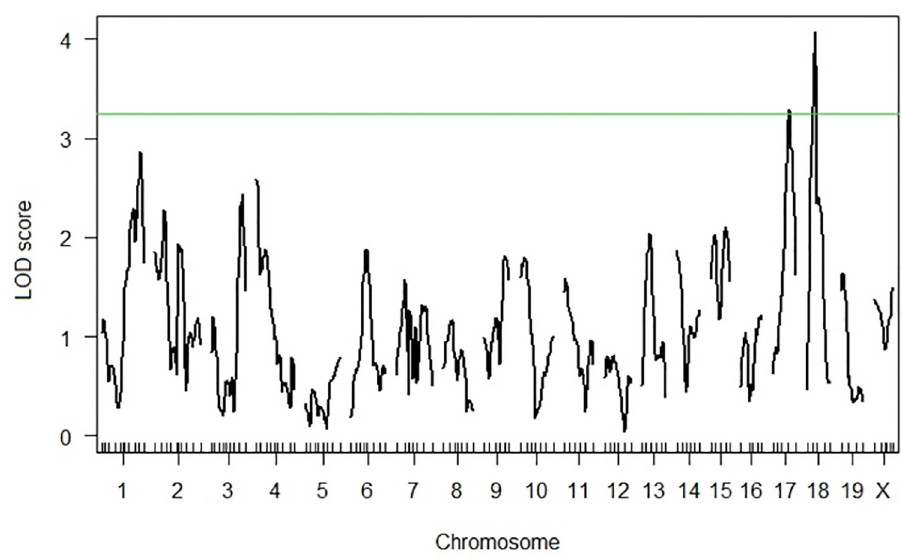
Fig 2. Whole genome LOD plot for the survival phenotype of the G59S-hDCTN1 mice. LOD plot of a whole genome scan for the Survival phenotype with pgm as an additive covariate and sex as an interactive covariate. Chromosome locations are on the X axis, LOD score on the Y axis. The green line indicates suggestive QTL threshold at a LOD of 3.2.